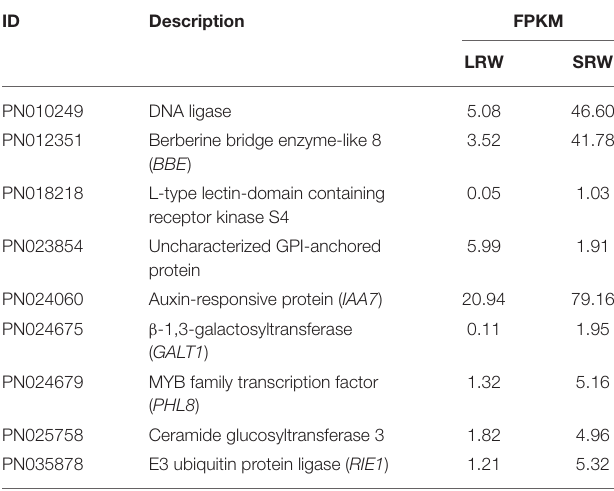
TABLE 1 | Identification of nine DEGs in P. notoginseng of different